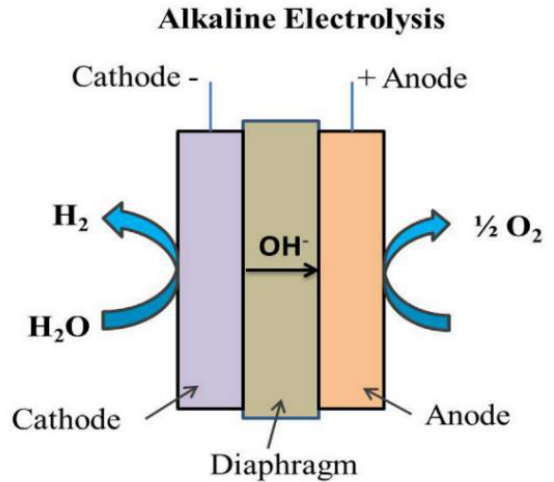
Figure 5. Alkaline electrolysis schematic. Reproduced with permission from Figure 5 . Alkaline electrolysis schematic. Reproduced with permission from [19].